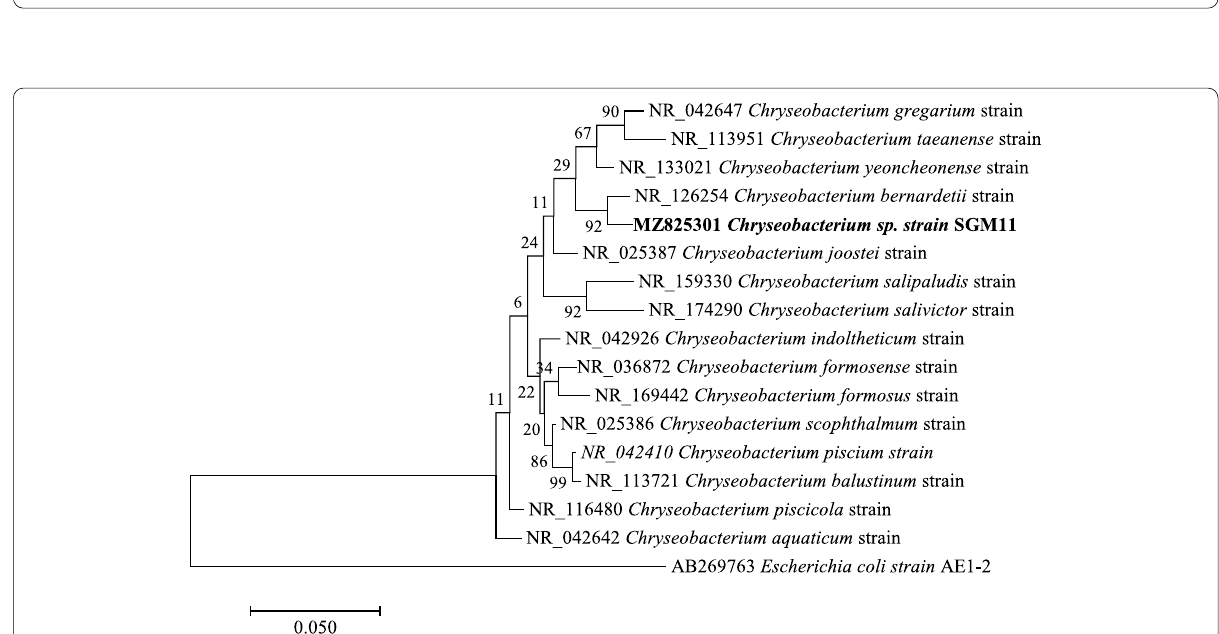
Fig. 3 Maximum likelihood phylogenetic tree based on analysis of partial 16S rRNA nucleotide sequence of Chryseobacterium sp. strain SGM11 with reference sequences selected from the NCBI . Escherichia coli strain AE1-2 was used as an